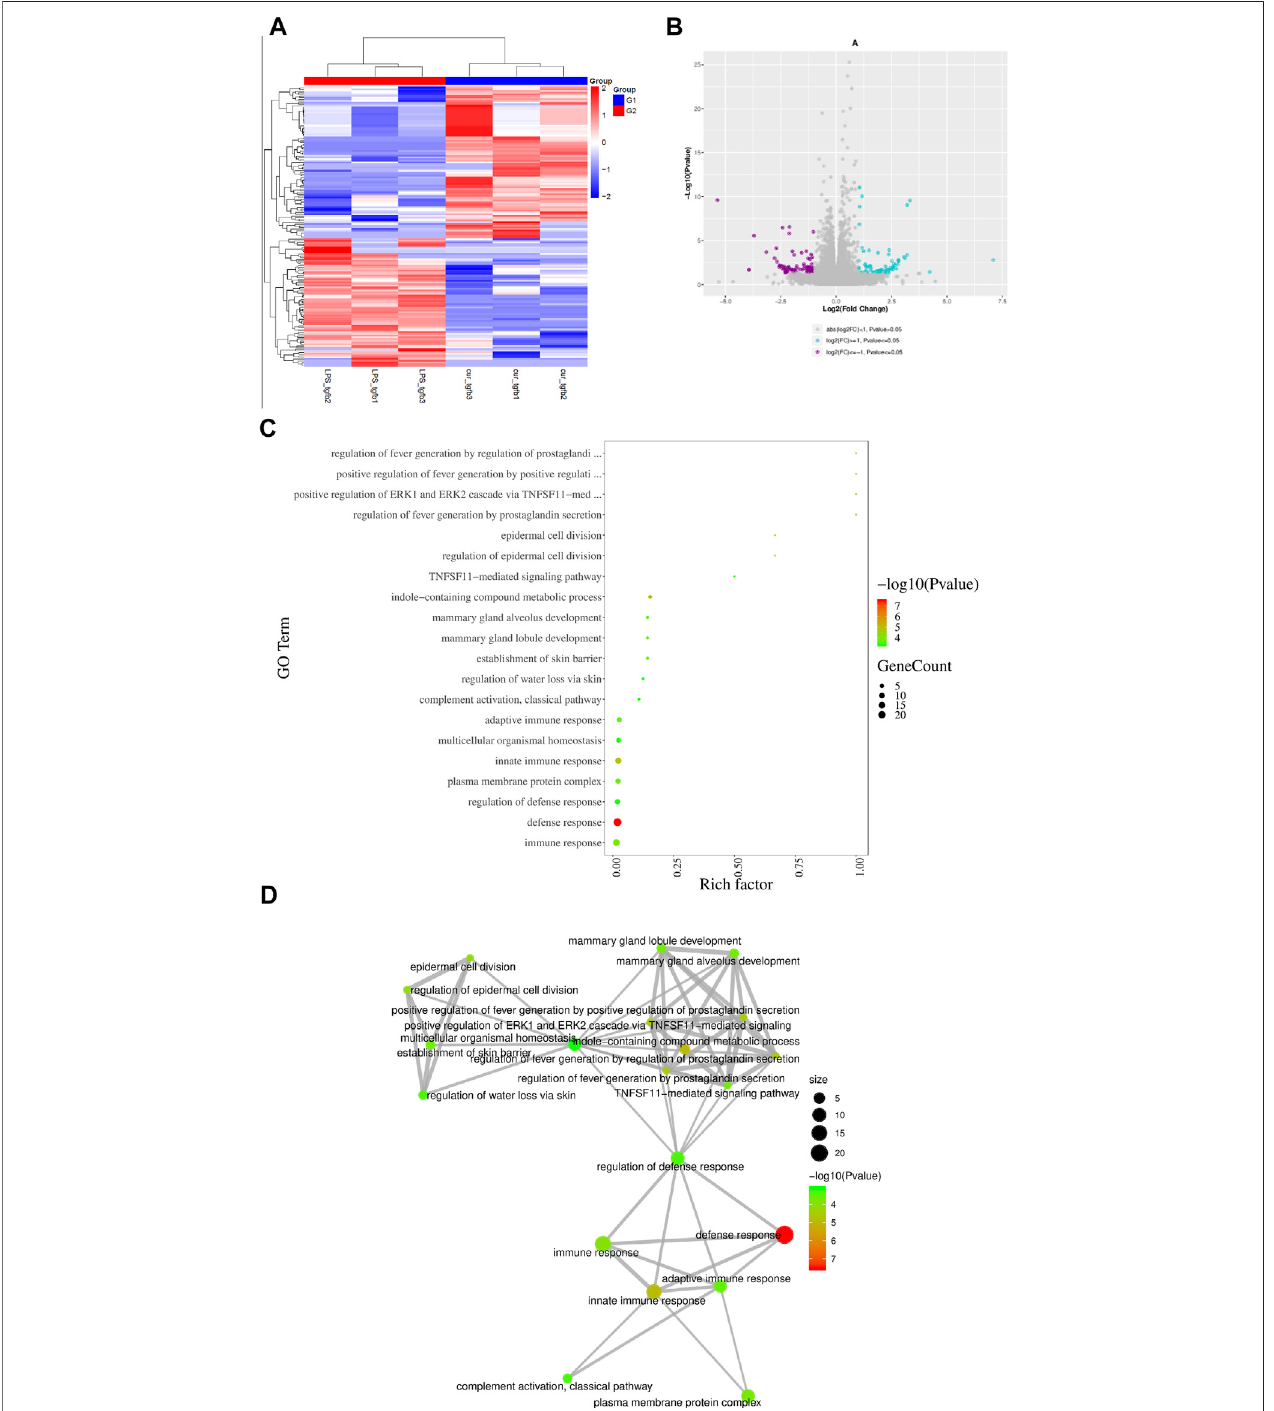
FIGURE 5 | IL-18 plays signi fi cant role in curcumin-mediated anti- fi brotic effect screened from mRNA sequencing (A). Difference gene heat map between two NRCF group (TGF- β +RAW (LPS), TGF- β +RAW (LPS + Cur)). N (cid:1) 3 in each group (B). Volcano plots indicating up-regulated genes and down-regulated genes between two groups. Purpledots represent down-regulatedgenes, blue dots representup-regulated genes, and grey dots represent no signi fi cant change. (C – D). GO signaling pathway enrichment analysis summary from respective groups. Different colors and dot sizes indicate gene number and gene alteration, respectively. Mutual correlation among all signaling enrichment observations are displayed in (D) .